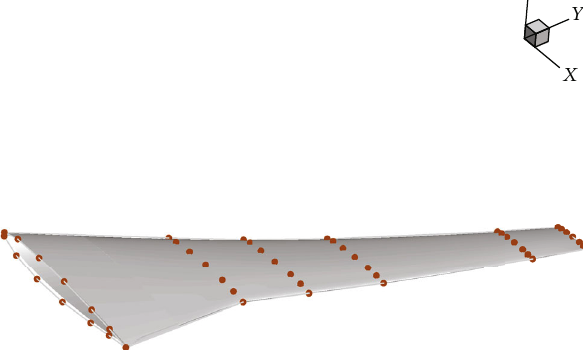
Figure 20: Shape design variables of